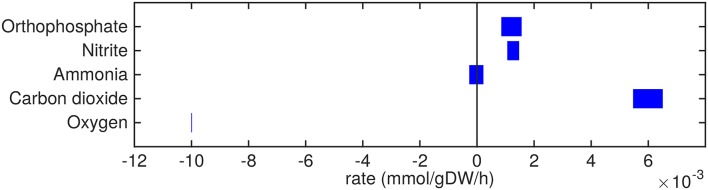
Predicted uptake and secretion rates of molecular oxygen, carbon dioxide and other small molecules by Mtb in the host. Predicted ranges of uptake and secretion rates (mmol gDW−1 h−1) of oxygen, carbon dioxide, and other small molecules by Mtb inside the host are indicated by blue bars. Negative values denote uptake and positive values denote secretion.